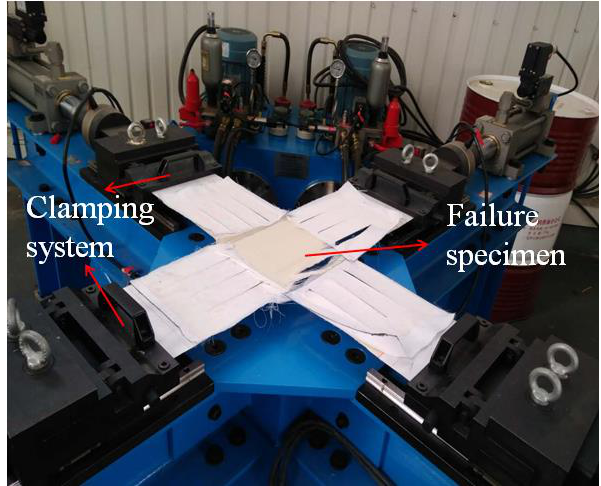
Figure 4. Failure mode of the biaxial tensile specimen.